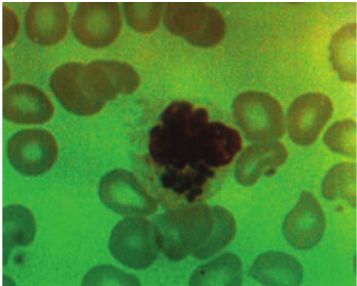
Figure 1 - CHS: blood smear with giant cytoplasmatic granules inside the neutrophils (case 1).